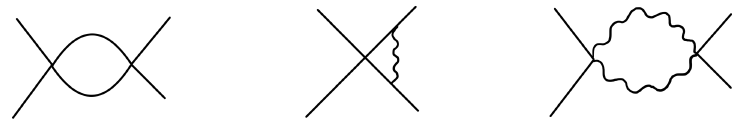
Figure 10 . The conjectured phase diagram of the theory at the self-dual coupling, with N f electric and N f magnetic fermions. The point when fermions are exactly massless is likely to be an interacting CFT.